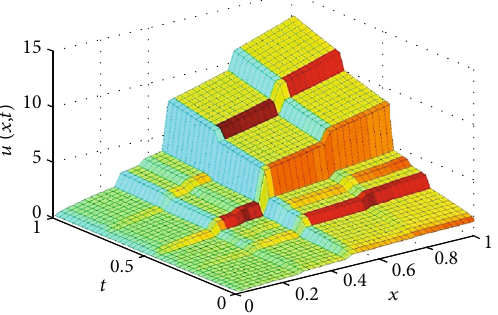
Figure 6: Variation of u ð x , t Þ versus x , t with α = ln 2/ln 3 , equation (71).